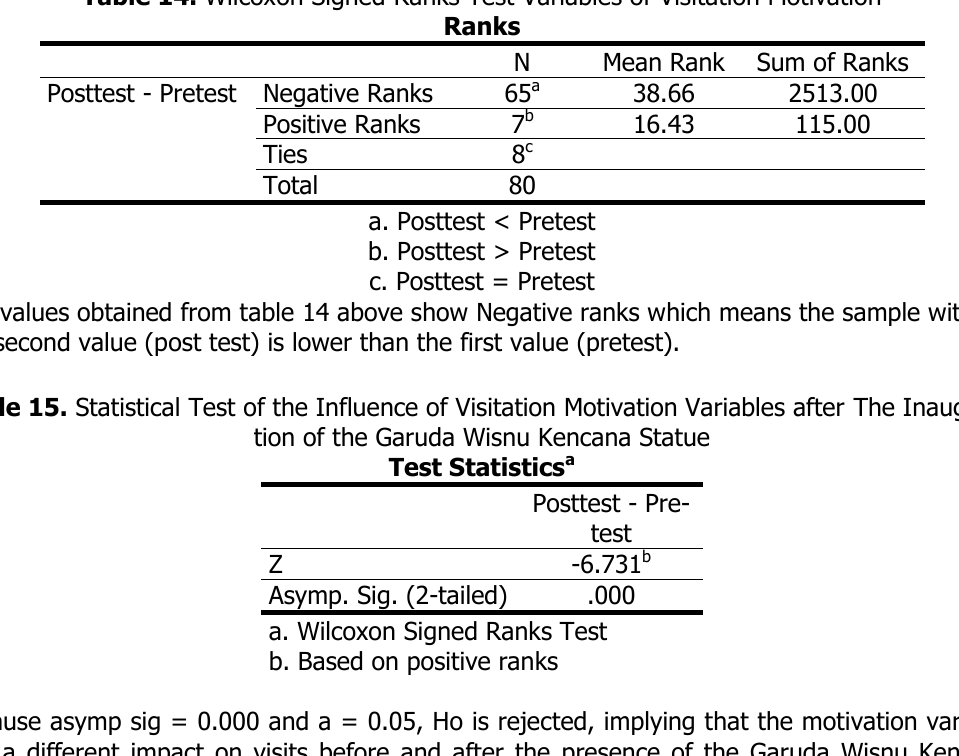
Table 14. Wilcoxon Signed Ranks Test Variables of Visitation Motivation